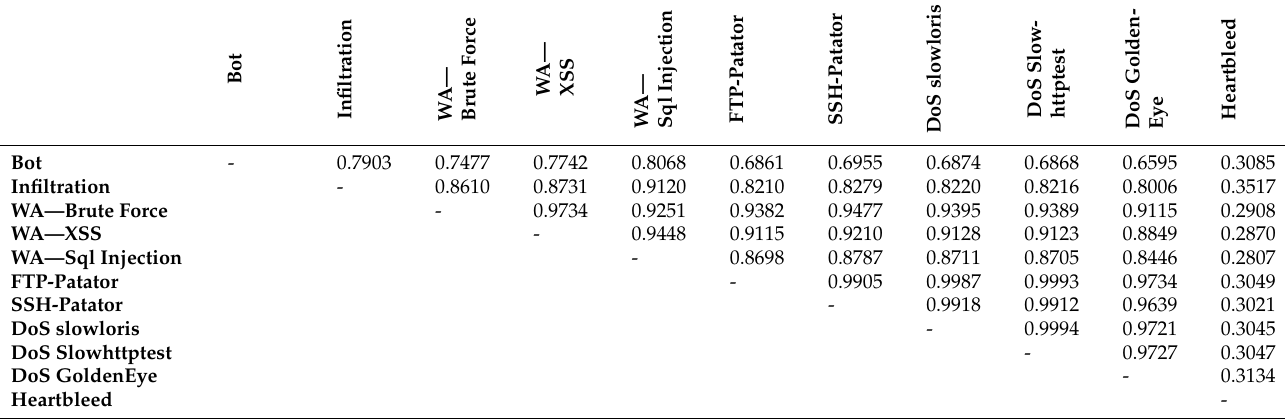
Table 5. The upper triangular matrix of sig com similarities between CICIDS2017 attack scenarios (WA—Web Attack).